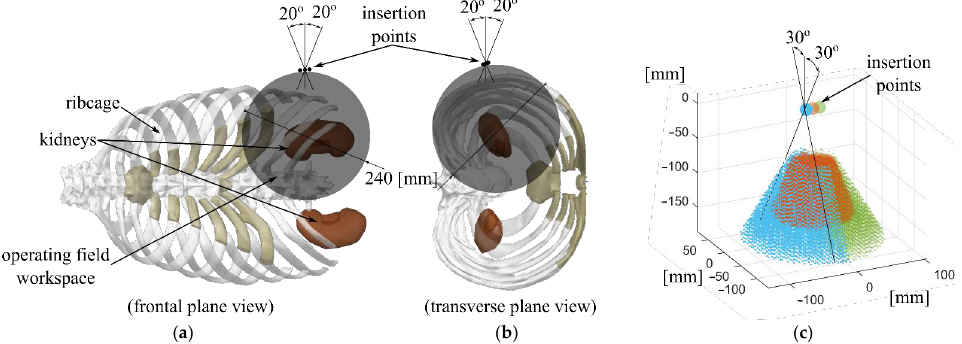
Figure 3. The proposed intraoperative workspace for the SILS robotic system: ( a ) frontal plane view showing the desired workspace with respect to the ribcage; ( b ) transverse plane view of the desired workspace; ( c ) the workspace of the surgical instruments with respect to the insertion points (brown — laparoscope, blue and green — active instruments).